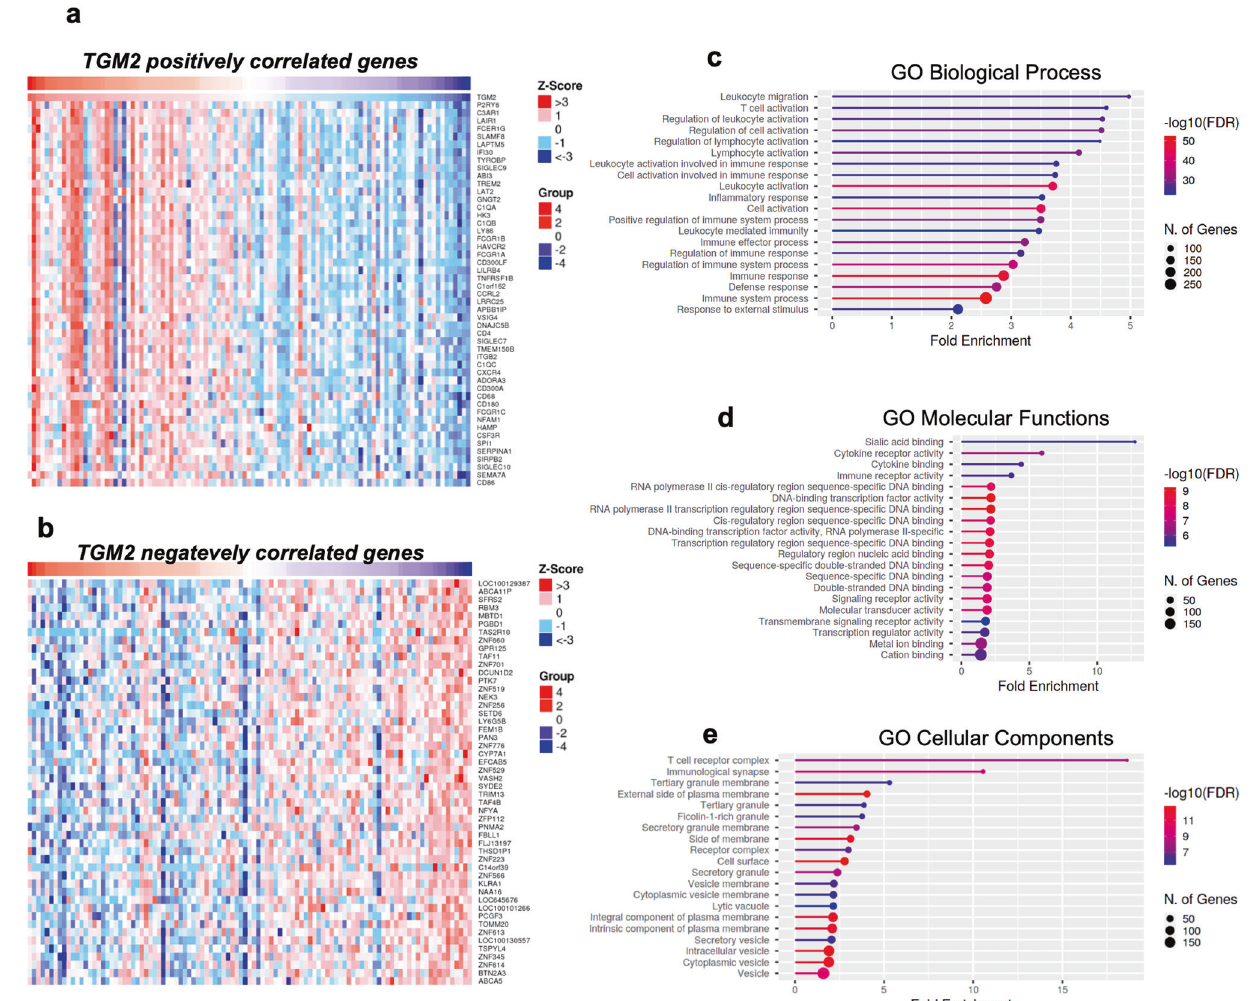
Fig. 4 TGM2 correlated differentially expressed genes and related pathways. a , b The top 50 positively and top 50 negatively TGM2 co- expressed genes were mapped using the TCGA SKCM dataset in the LinkedOmics database, according to their ranking based on their Z -score through Pearson Correlation analysis. c – e GO analysis obtained through Gene Ontology Enrichment Analysis performed on ShinyGO, using the top 1000 TGM2 positively correlated genes based on their p -value in SKCM (BP, biological process; CP, cellular component; GO, Gene Ontology; MF, molecular function). Data were plotted as per fold enrichment, for the -log10 of the false-discovery rate (FDR) and the p -values,